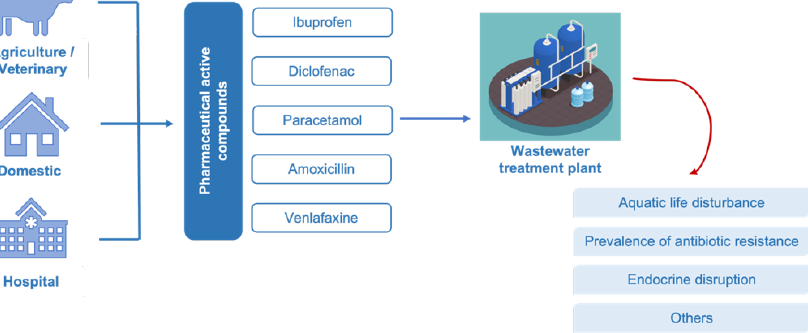
Figure 1. Path of pharmaceuticals active compounds from the use to the disposal in the environment with some of the ecological side effects.